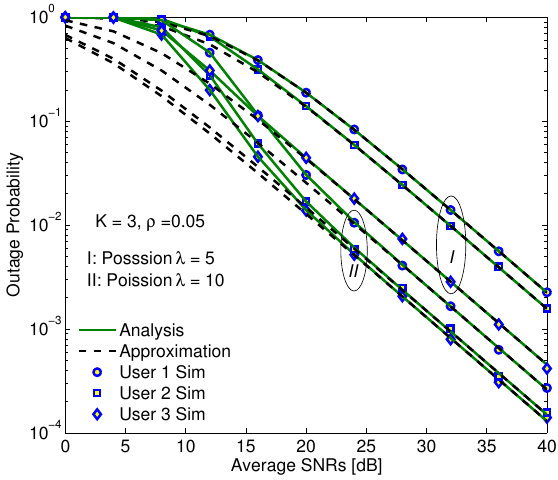
Figure 5. The OP versus SNRs of users with parameters as α = 0.3, η = 0.85, a 1 = 0.6, a 2 = 0.3, a 3 =